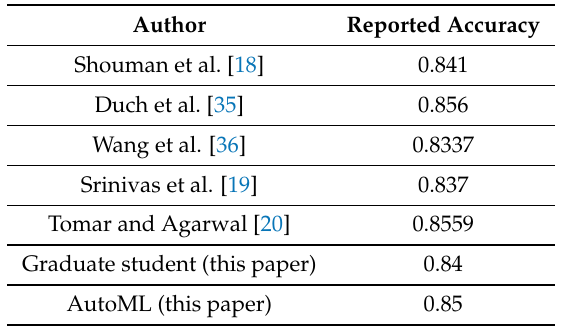
Table 5. Accuracies reported by previous studies on the Heart UCI Dataset compared to accuracies of the graduate student and